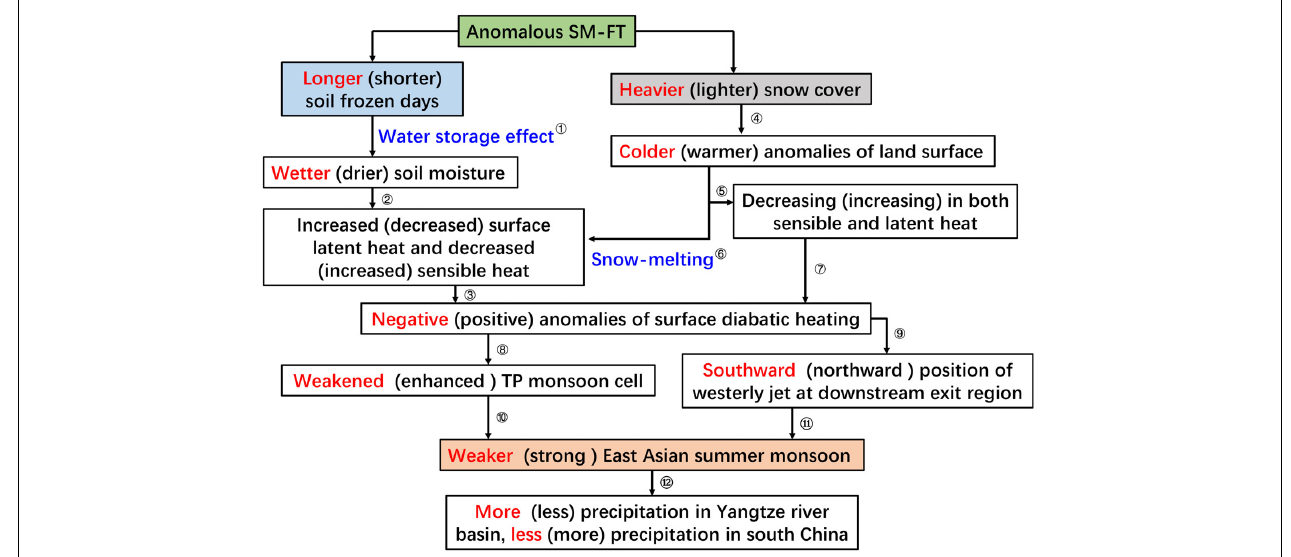
FIGURE 8 | Schematic diagram of the physical mechanism associated with the impacts of surface diabatic heating anomalies induced by snow melting and freeze–thaw anomalies on East Asian summer monsoon. This is a summary graphic derived from previous studies (i.e., (cid:172) : Wang and Shang, 2007; Yang and Wang, 2019a; (cid:173) , (cid:174) : Seneviratne et al., 2010; Zhang and Zuo, 2011; Yang and Wang, 2019b; (cid:175) , (cid:176) , (cid:177) , (cid:178) : Zhang and Tao, 2001; Qian et al., 2003a,b; Xiao and Duan, 2016; Wang C. et al., 2017; Duan et al., 2018; (cid:179) , (cid:180) : Yanai et al., 1992; Zhang et al., 2004; Zhu and Ding, 2007; Wang C. et al., 2017; (cid:181) , , : Qian et al., 2003a; Wang et al., 2003; Wu and Qian, 2003; Zhang et al., 2004; Shang and Wang, 2006; Zhu and Ding, 2007; You et al., 2020.